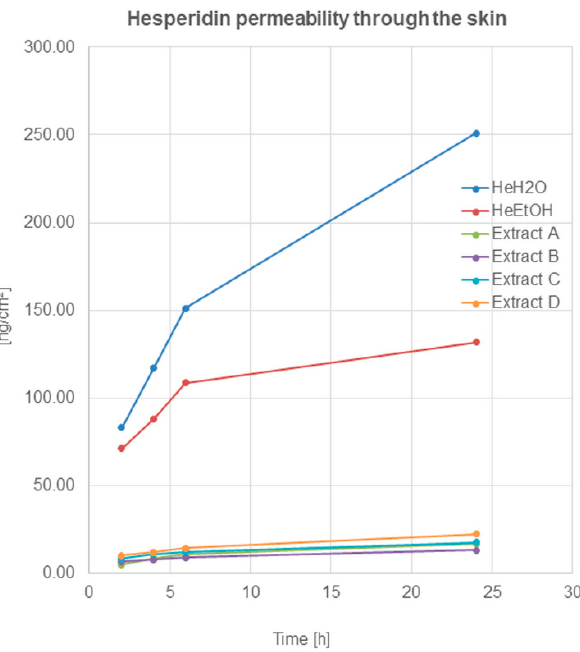
Figure 2. Hesperidin permeation through the skin after 2, 4, 6, and 24 h (ng/cm 2 ) from the application of hesperidin solutions: water (HeH 2 O, 4 µ g/mL), ethanol (HeEtOH, 4 µ g/mL, 50% ( v/v )), or of hesperidin solutions: water (HeH 2 O, 4 μ g/mL), ethanol (HeEtOH, 4 μ g/mL, 50% ( v/v )), or honey ‐ honeybush extracts: A, B, C, bush extracts: A, B, C, D.